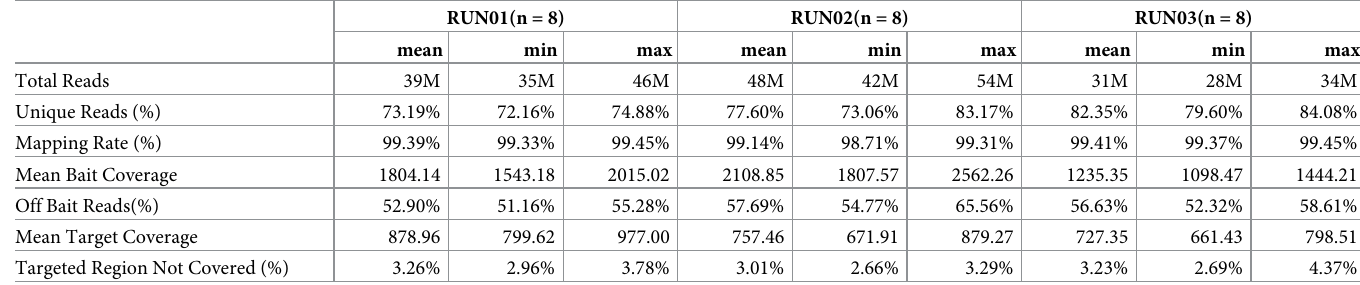
Table 1. Performance metrics of ActSeq